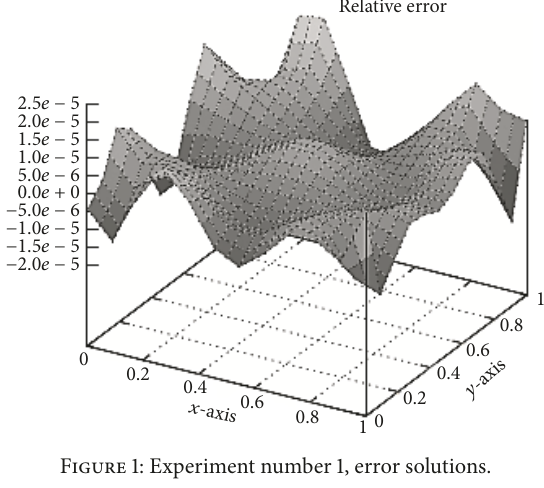
Figure 1: Experiment number 1, error